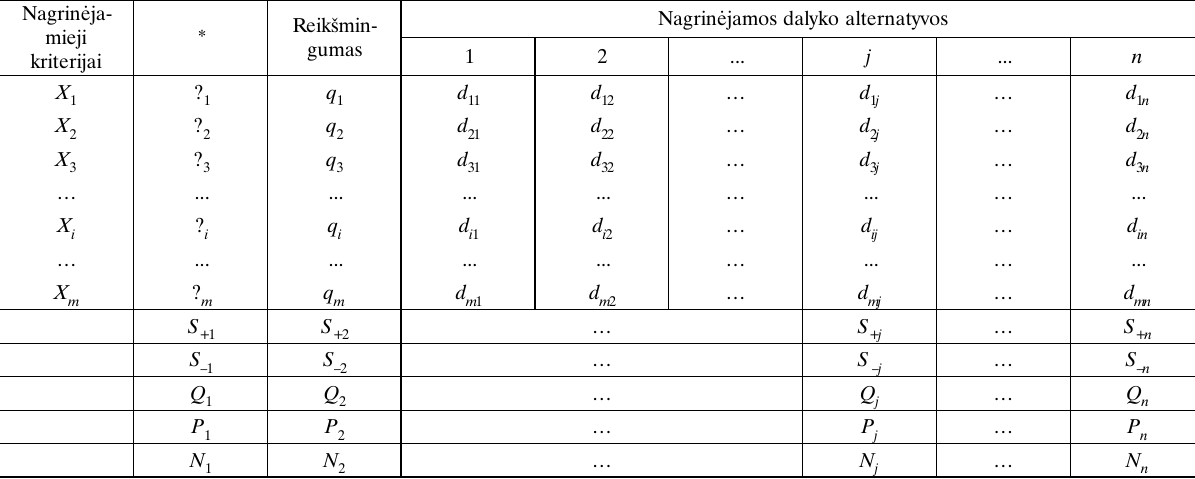
Table 1. The results of multivariant analysis of an optional